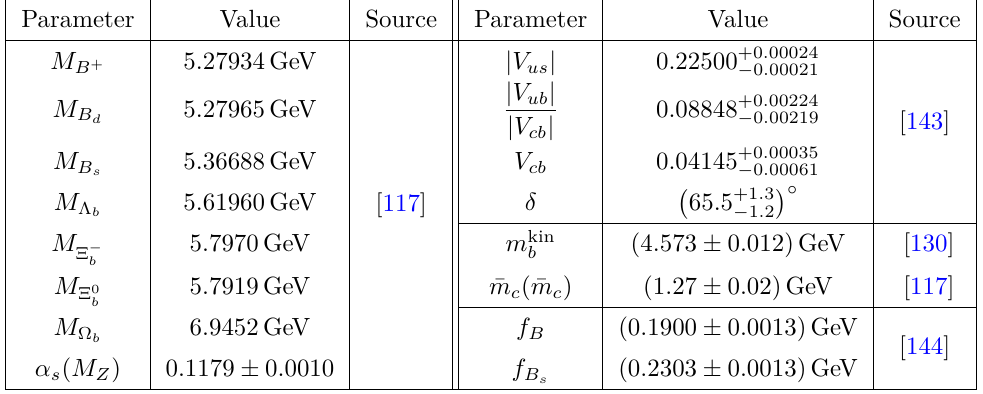
Table 7 . Summary of inputs used in the numerical analysis. Values of the non-perturbative parameters for b -baryons are presented in tables 4 and 5.